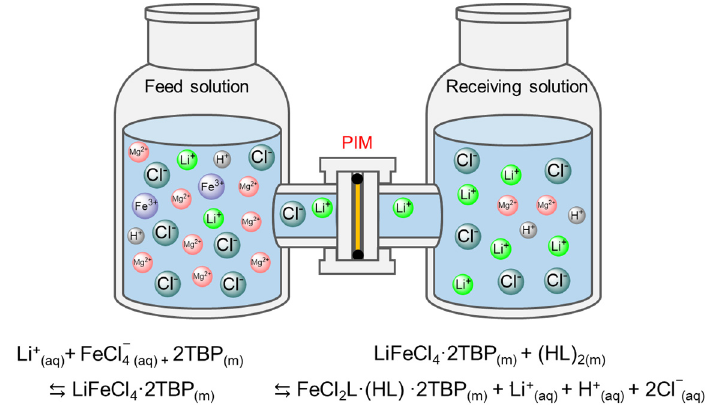
Figure 2. Schematic diagram of Li + transport experiment: aq and m mean aqueous phase and mem- brane phase, respectively.